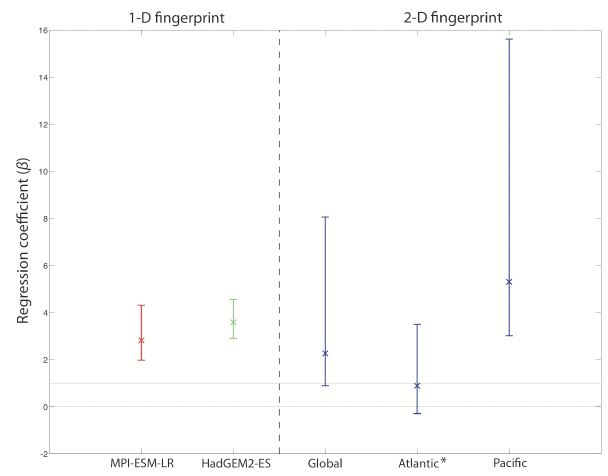
Fig. 8. Best estimates and 5–95% uncertainty ranges of regression coefficients ( β) from single fingerprint optimal detection analysis. Two types of model response pattern are projected onto dissolved oxygen observations. Left: a 1-D global depth-averaged (100–3000m) zonal mean [O 2 ] change using MPI-ESM-LR ( k = 40) and HadGEM2-ES ( k = 31). Right: a 2-D depth-resolving zonal mean [O 2 ] change globally and for the Atlantic and Pacific Ocean basins ( k = 49) using MPI-ESM-LR only (* indicates a failed residual consistency test at all EOF truncations).